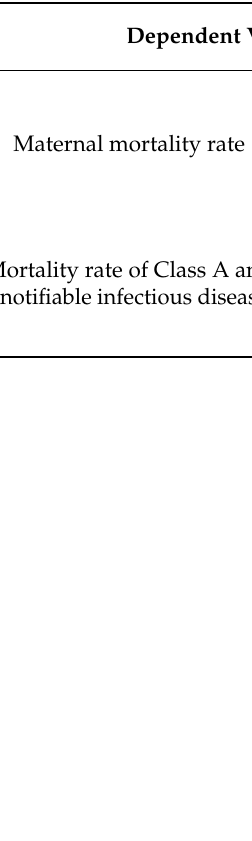
Table 5. Games–Howell multiple comparison